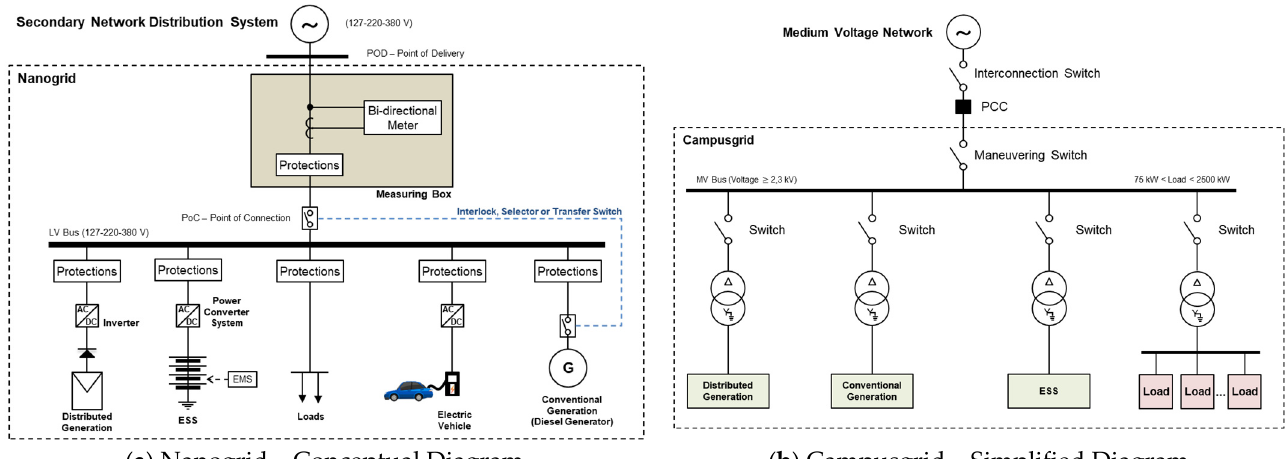
Figure 3. Schematic single line diagram. ( a ) Nanogrid and its DERs, with AC coupling; ( b ) generic scheme of a Campusgrid microgrid. Adapted from CPFL Utility Technical Requirements GED 13